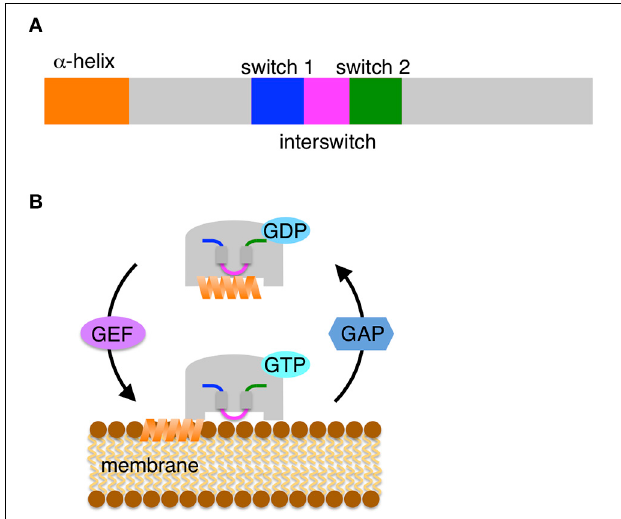
FIGURE 1 | Small GTPase Sar1/Arf1 protein. (A) Schematic diagrams of Sar/Arf. Conserved domains are depicted: the N-terminal amphipathic α -helix, two switch regions (switch 1 and switch 2) and the interswitch region. (B) The Sar/Arf protein cycles between membrane-association and dissociation. GDP-bound cytosolic Sar/Arf is inactive and carries the N-terminal amphipathic helix in a hydrophobic pocket. A guanine nucleotide exchange factor (GEF) mediates the exchange of GDP for GTP in Sar/Arf. GTP-loaded Sar/Arf undergoes a conformational change of the two switch and interswitch regions, triggering the extrusion of the helix from the pocket. Subsequently, the shallow insertion of the amphipathic helix into the outer leaflet of the lipid bilayers allows Sar/Arf to associate tightly with the membrane surface. For dissociation, GTPase activating protein (GAP) activates the GTP hydrolysis activity of Sar/Arf. Conserved domains are shown in the same color in (A) and (B)